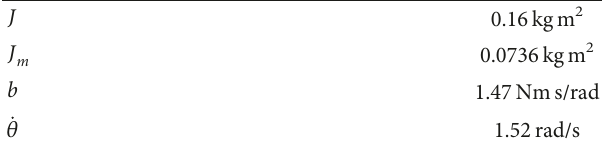
Table 2: The system physical parameters.